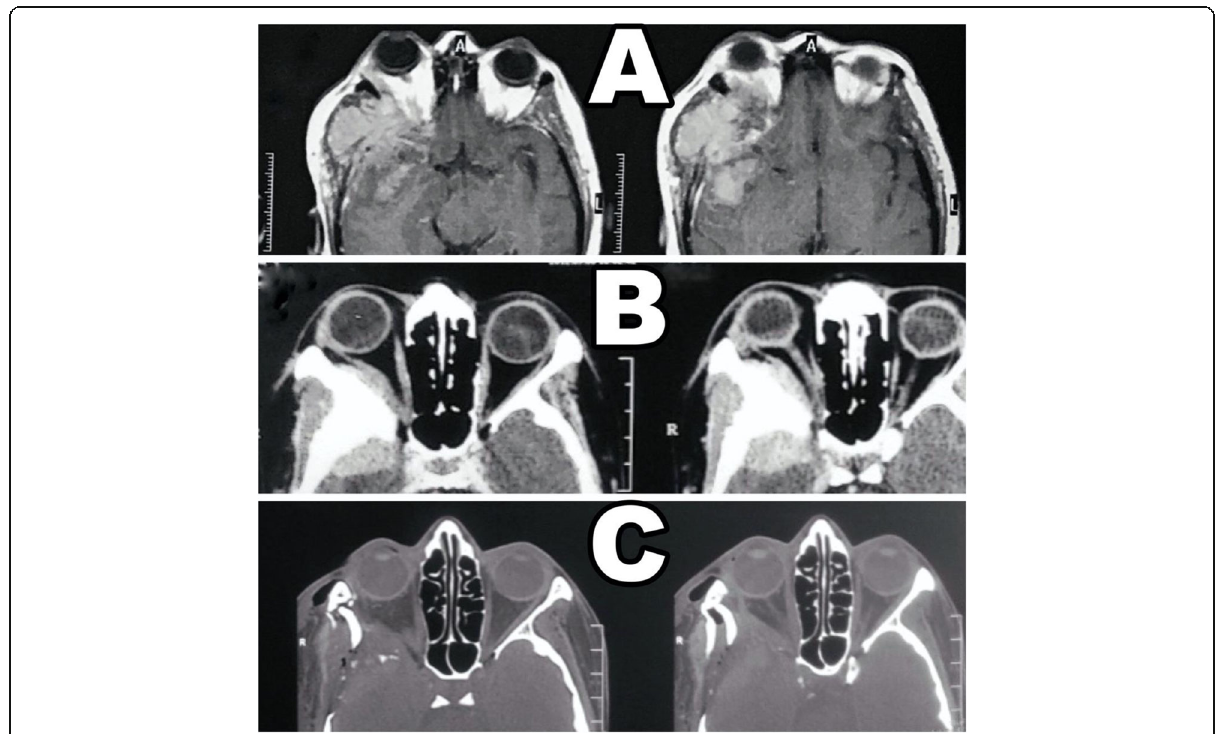
Fig. 2 Right side SOM. Axial CT scan before and after surgery. A 58-year-old female patient operated via the pterional approach. The tumor was extending through the bone and under the temporalis muscle. The invaded pathological bone flap was removed. The tumor was found to invade the dura and the temporal lobe. Anterior clinoidectomy was performed, with drilling of the optic canal. Gross total resection was achieved (Simpson grade I). The dura was resected and reconstructed using a temporalis fascia graft. Regression of the existing proptosis was noted in the immediate postoperative